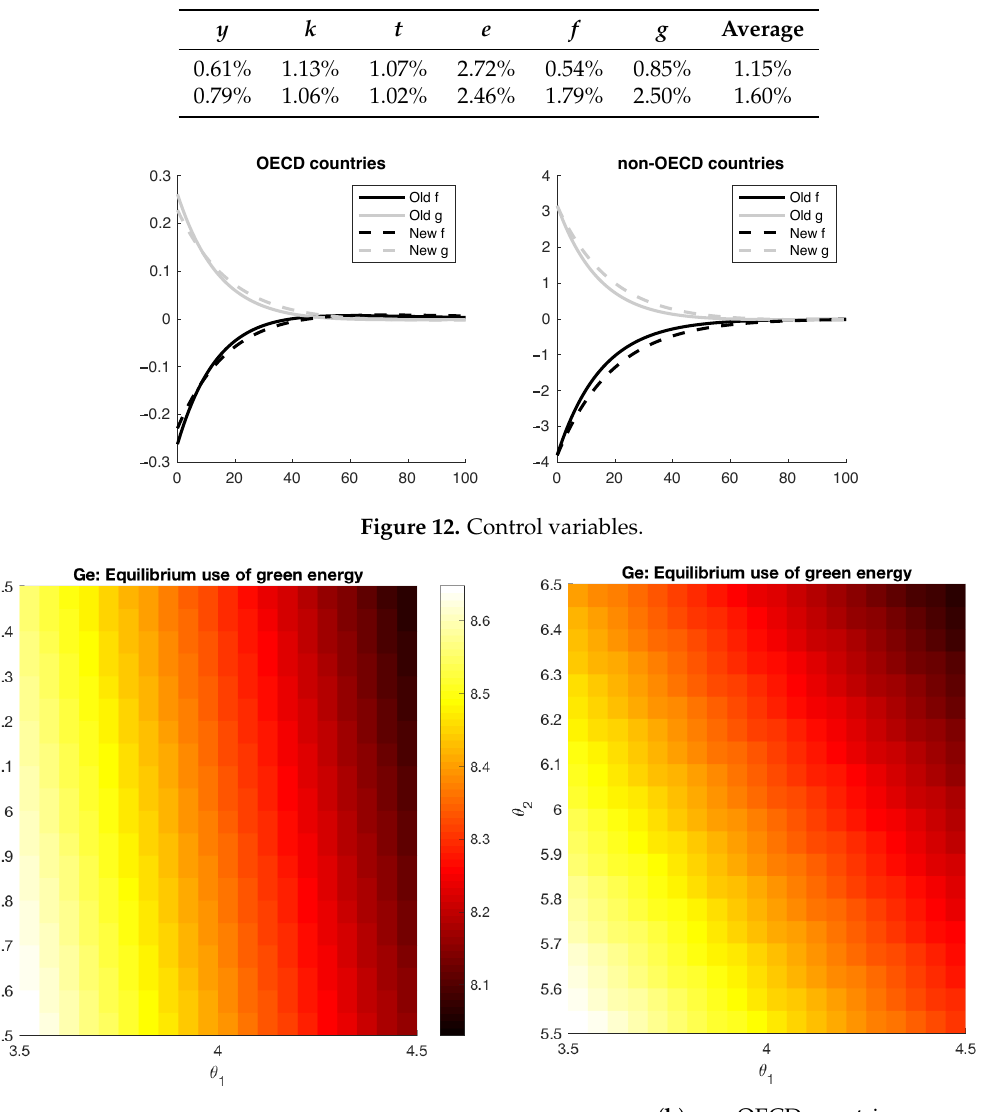
Table 11. Percentage difference from original equilibrium.